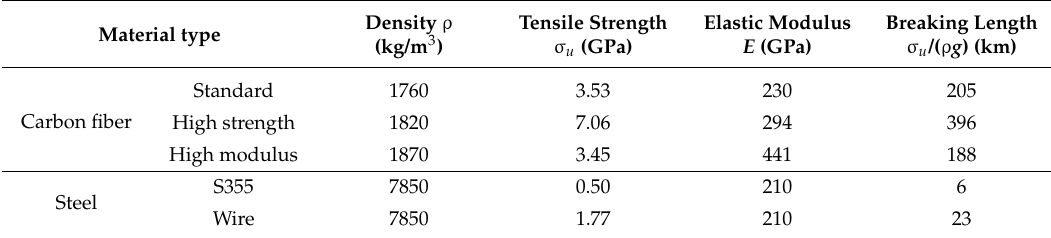
Table 1. Mechanical properties of carbon fibers compared with steel materials.